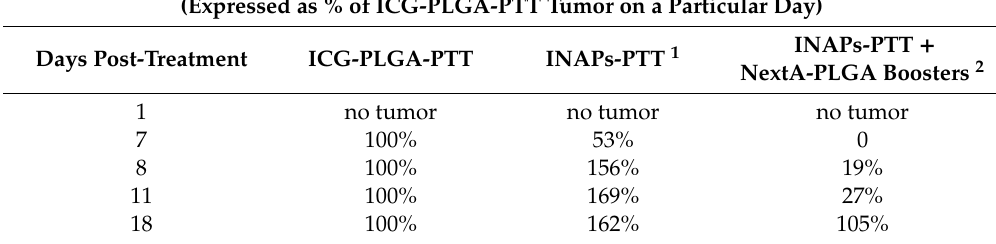
Table 2. Quantitative comparison of tumor sizes in mice several days after INAPs-PTT and INAPs-PTT + NextA-PLGA booster treatments, relative to